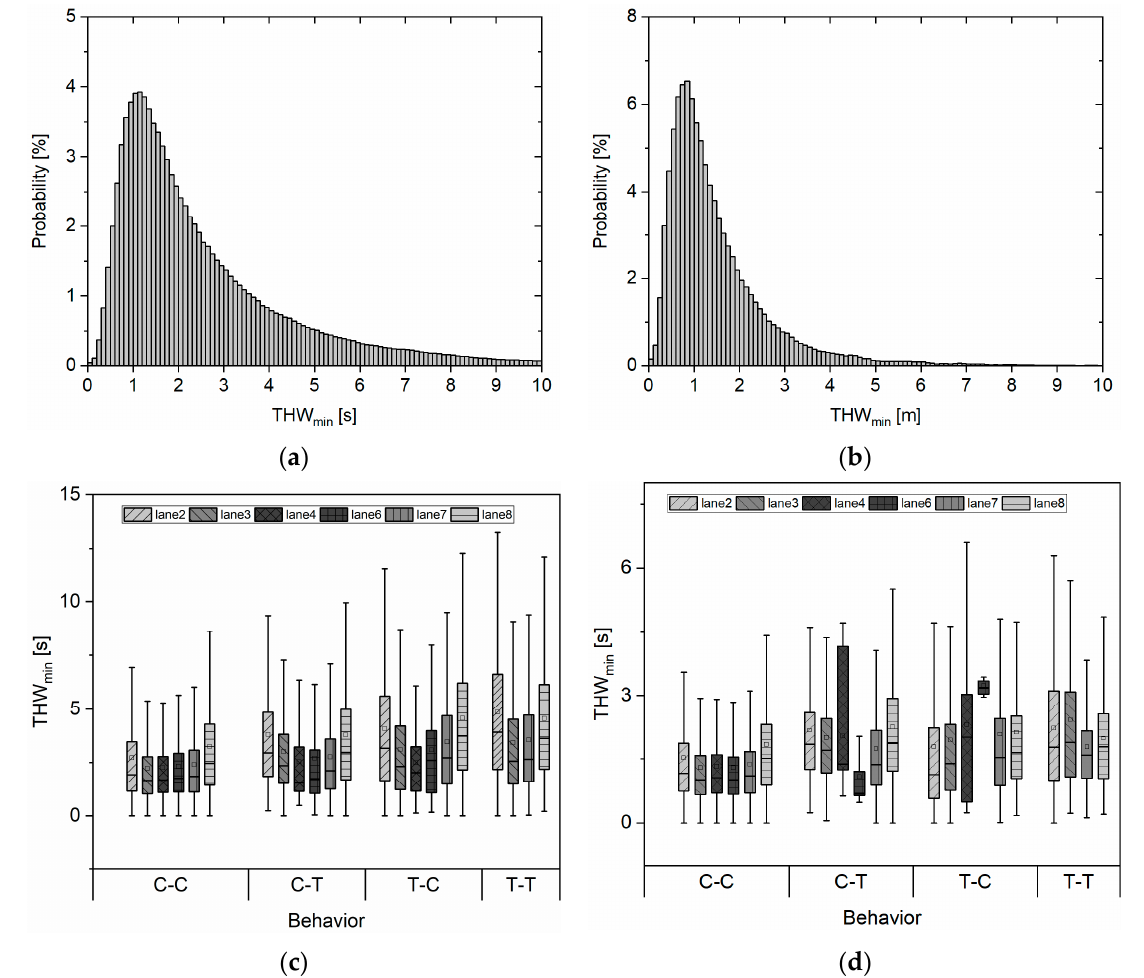
Figure 13. Probability distribution of THWmin when car following ( a ) and lane changing ( b ); THWmin when car following ( c ) and lane changing ( d ) for different following behavior in different lanes.